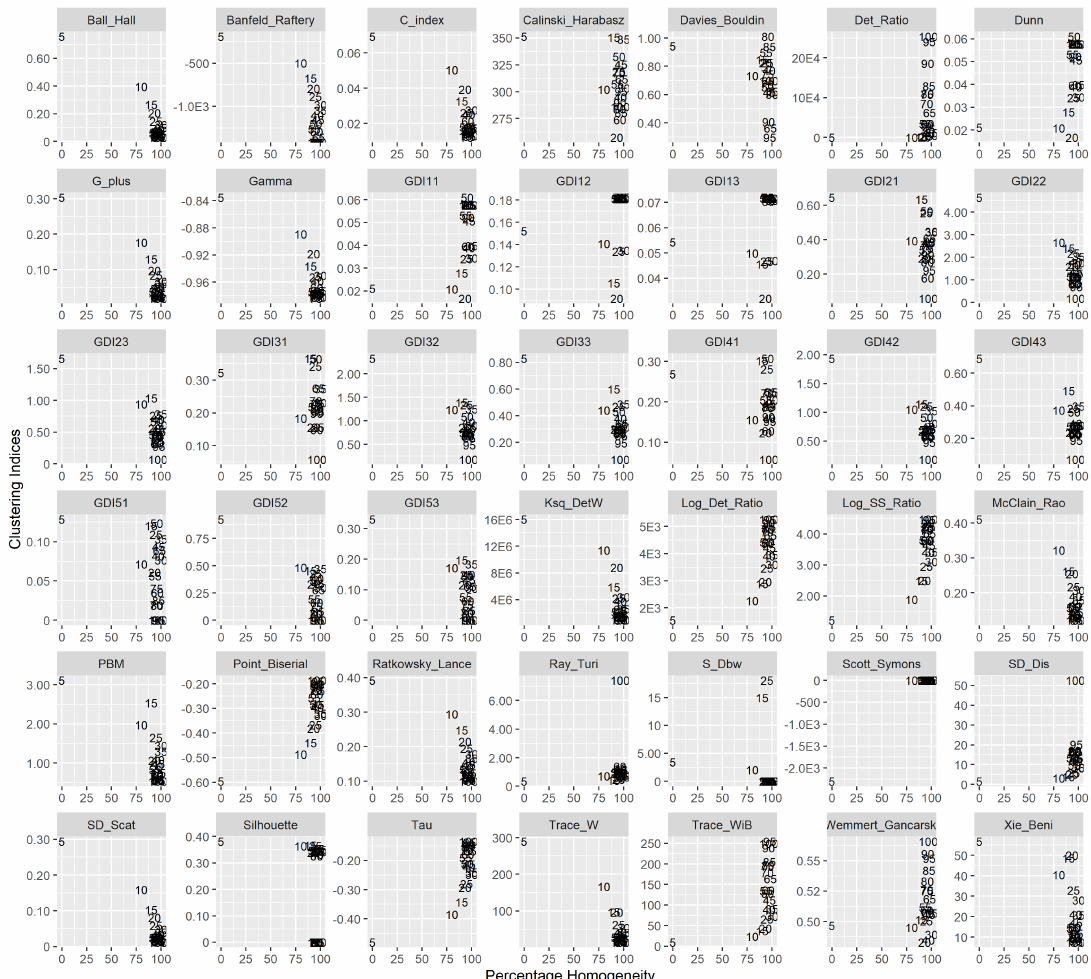
Figure 11. Performance of cluster validity indices in GL-SL region—Summer season. The numbers indicate the percentage homogeneity for the number of clusters in the x-axis and index value on the y-axis. The scientific notation ’E’ used in labels of y-axis represent ‘10 to the power